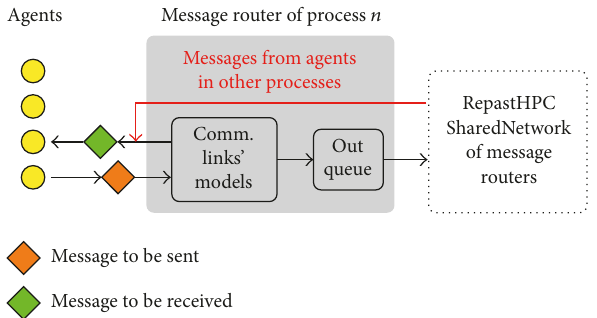
Figure 6: Modeling of communication infrastructure with message routers in process 𝑛 .